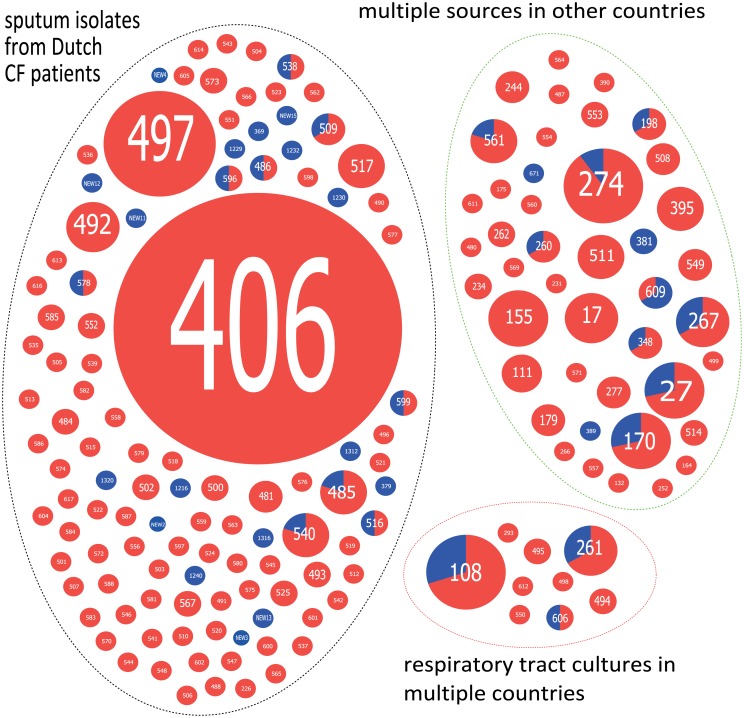
Distribution of P. aeruginosa genotypes.Distribution of 163 P. aeruginosa STs detected in 265 Dutch CF patients in 2007 and 49 patients with acquisition after segregation in 2011 among defined source groups. The 41 STs detected in 49 patients with acquired infection during segregation are indicated in blue and STs detected in the cross-sectional study in 2007 are depicted in red. Each circle represents an ST and size of circles represents number of isolates. Dotted circles enclose defined source groups. Assignment of STs to source groups is based on source group definition of STs, contained in the international pseudomonas MLST database (http://pubmlst.org/paeruginosa/), that are identical to the 163 STs identified in Dutch CF patients.